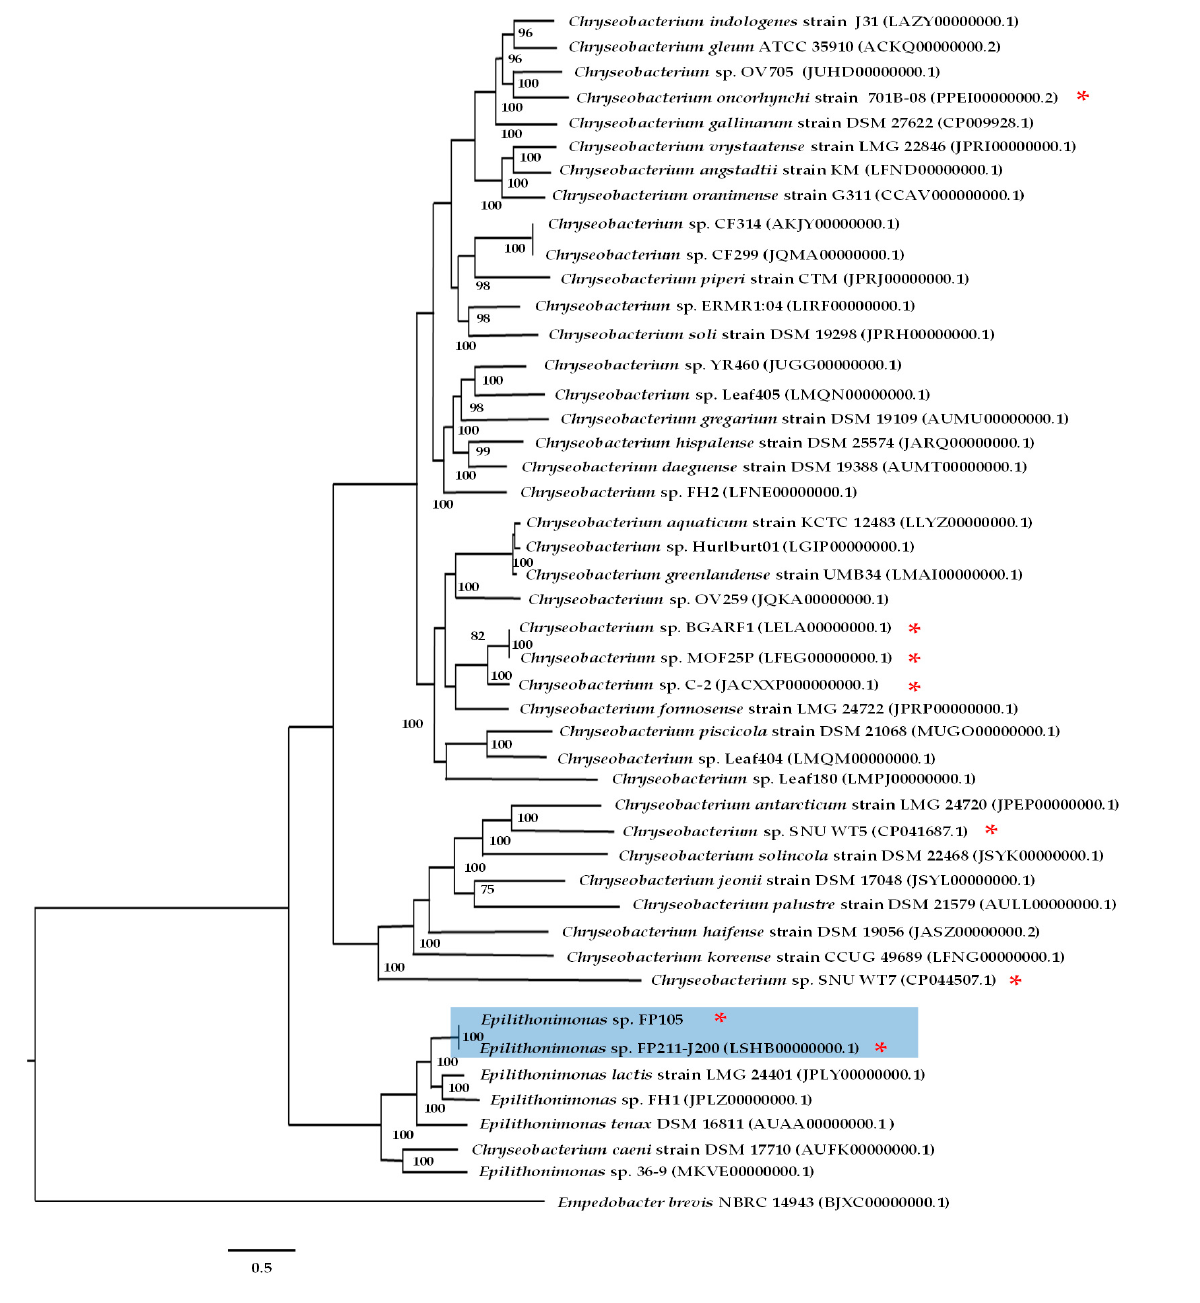
Figure 2. Phylogenetic tree based on the whole genome sequences, showing the relationship between the Chilean Epilith- onimonas strains (FP105 and FP211-J200) and closely related taxa within the Chryseobacterium clade. Tree was constructed using the patric server (https://patricbrc.org/app/PhylogeneticTree, accessed on 12 July 2021). A total of 100 single-copy genes found for 46 genomes and both amino acid and nucleotide sequences were used for each gene. Empedobacter brevis NBRC 14943 was used as an outgroup. Accession numbers of each sequence are shown in parentheses. Red asterisks (*) are included to highlight genomes harboring the tet (X) gene.